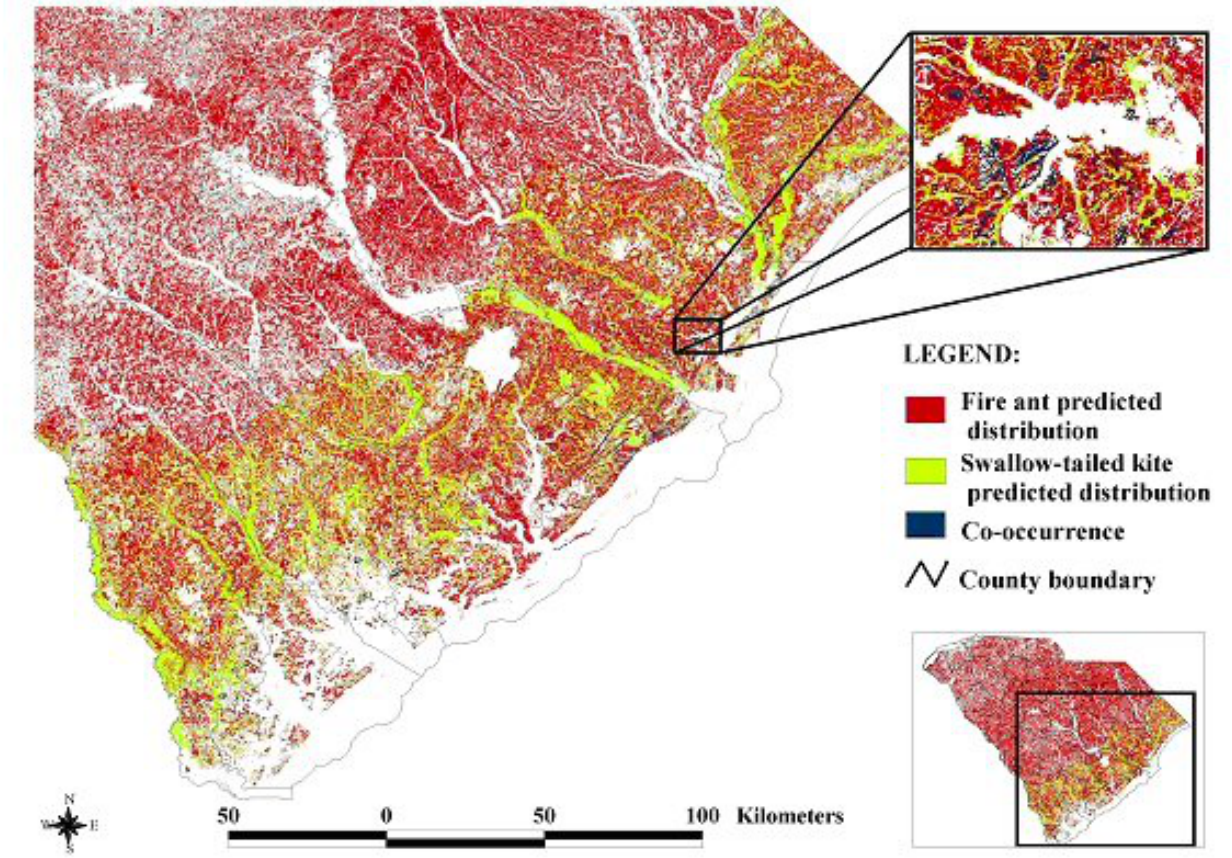
Fig. 4. Spatial correspondence of swallow-tailed kite ( Elanoides forficatus ) predicted distribution and red imported fire ant ( Solenopsis invicta ) predicted distribution in South Carolina, USA, at a 30 m resolution. The map of the swallow-tailed kite based on predictive habitat model developed by the South Carolina Gap Analysis Program, an approach that models potential habitat within the known geographic range of a species. Red imported fire ant predicted distribution based on logistic regression analysis of statewide presence/absence ant sampling (Fig. 1). Seven percent of swallow-tailed kite’s predicted distribution is shared with fire ants with spatial co-occurrence represented in